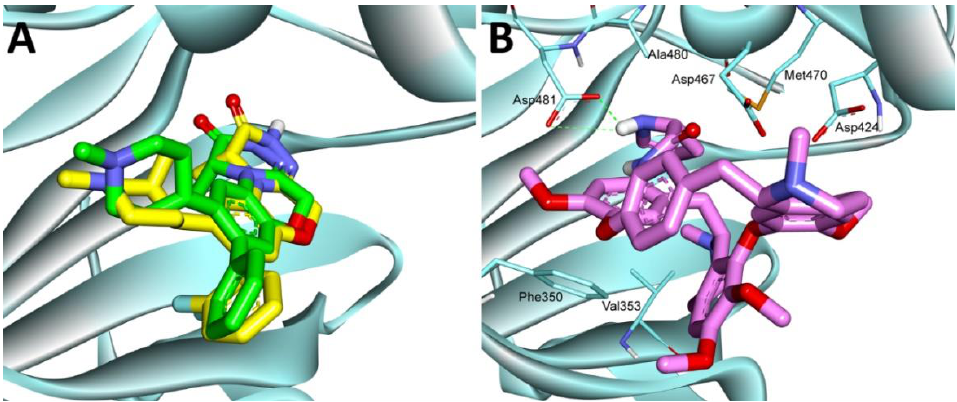
Figure 10. Binding mode analysis of 16 . ( A ) Overlay of co-crystallized 28 (green carbon) and re- docked 28 (yellow carbon) with PKC- α (PDB ID: 4RA4). ( B ) Binding mode of 16 (pink carbon) in complex with PKC- α . PKC- α is shown in cyan.